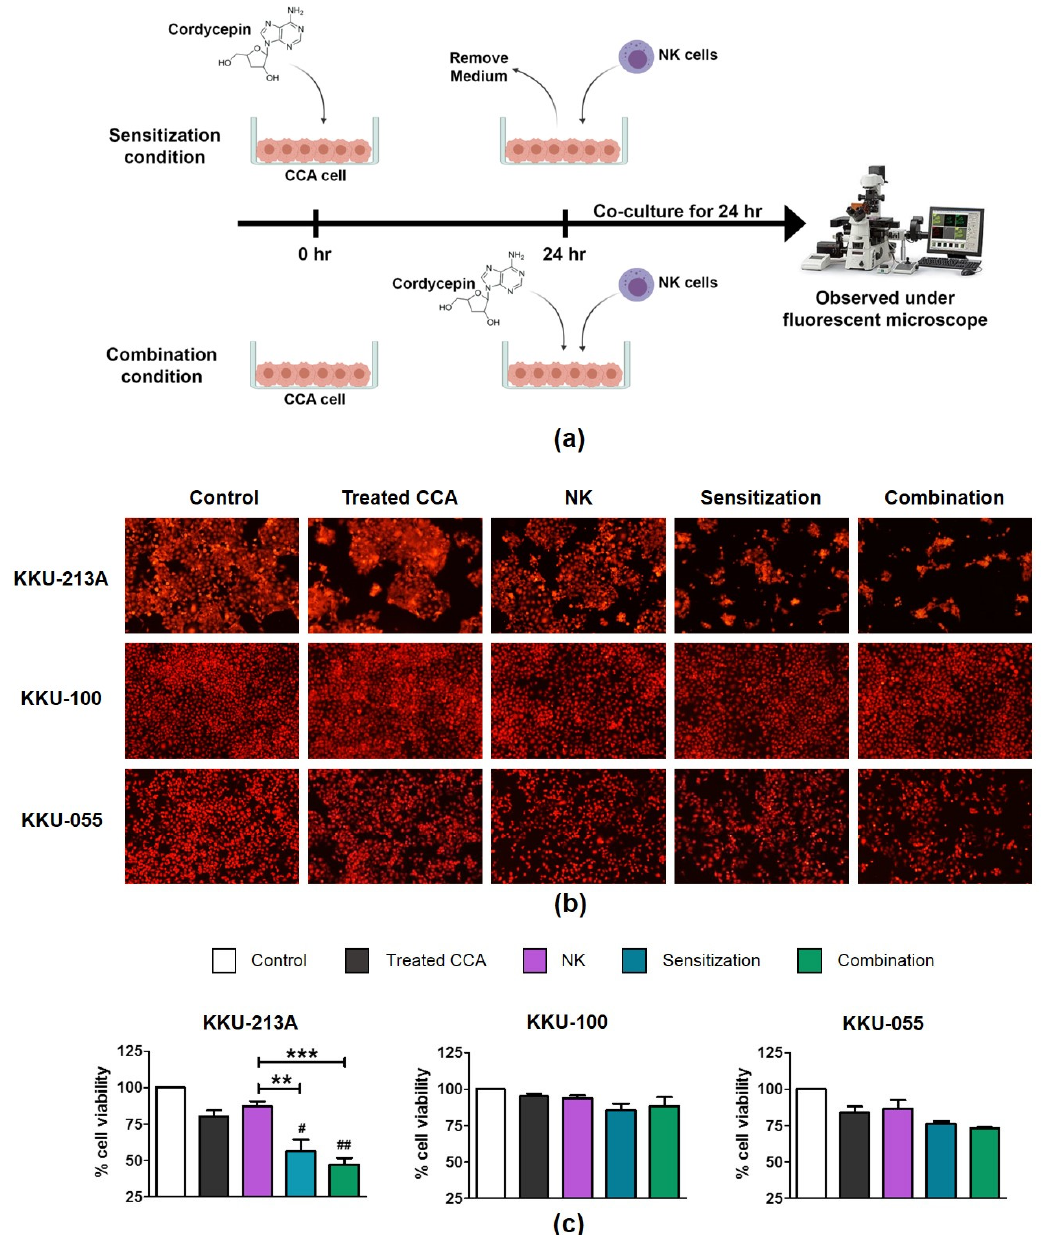
Figure 2. Effect of cordycepin on enhancing NK-92 cytotoxicity to kill CCA cells. The scheme represents the testing conditions used to investigate the cordycepin effect on enhancing NK cell cytotoxicity ( a ). The effect of cordycepin at a concentration of 50 µ M to enhance NK killing ability was determined in KKU-213, KKU-100, and KKU-055, by killing assay. The killing assay was conducted with 24-hour incubation time using the E/T ratio of 1:1. The number of living cells after NK cell co-culturing under sensitization and combination conditions was observed under the fluorescence microscope ( b ). The fluorescence-intensity was measured and represented as %cell viability compared to a no-treatment control set at 100% ( c ) . The statistical differences were analyzed comparing combined cordycepin-NK treatment vs. single NK treatment, in which ** indicates p < 0.01; and *** indicates p < 0.001, whereas the statistical differences between combined cordycepin-NK treatment and single cordycepin treatment are designated as # indicates p < 0.05; and, ## indicates p < 0.01.